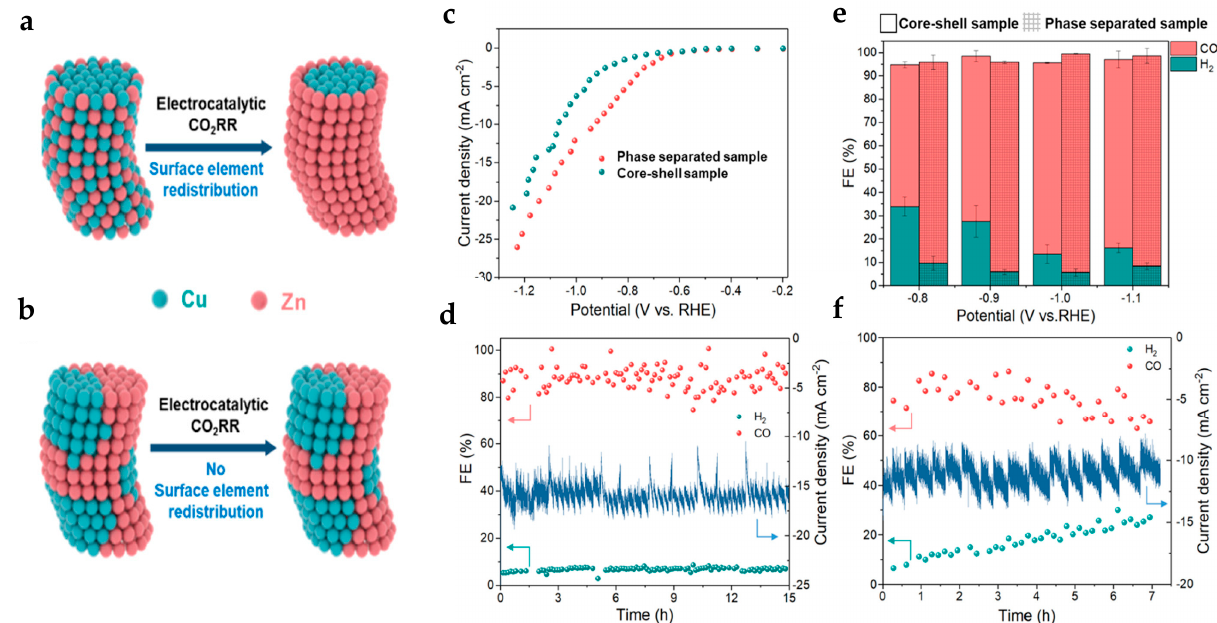
Figure 10. Schematic illustration of surface element redistribution in ( a ) core–shell and ( b ) phase- separated samples. Electrochemical CO 2 reduction performance. ( c ) Linear sweep voltammetry curves of phase-separated and core–shell samples in a CO 2 -saturated 0.1 M KHCO 3 solution. ( e ) FE of the main products of core–shell and phase-separated samples. The long-term stability test of ( d ) phase-separated and ( f ) core–shell samples. Reprinted (adapted) with permission from [77]. Copyright 2022, American Chemical Society.